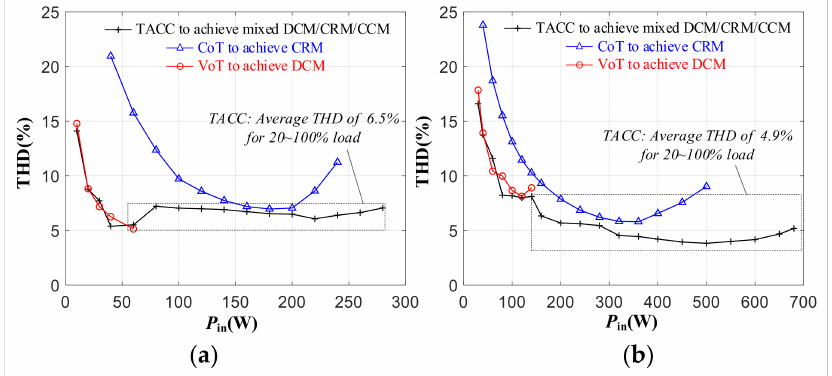
Figure 19. Measured THDs. ( a ) v in = 110 VAC; ( b ) v in = 220